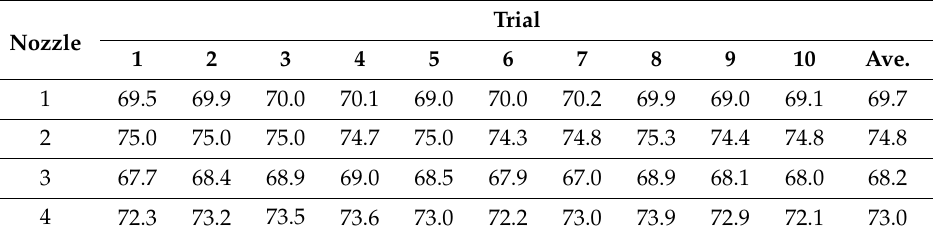
Table 4. Flowrate (mL min − 1 ) of four ACF Greenhouses poly mist nozzles.